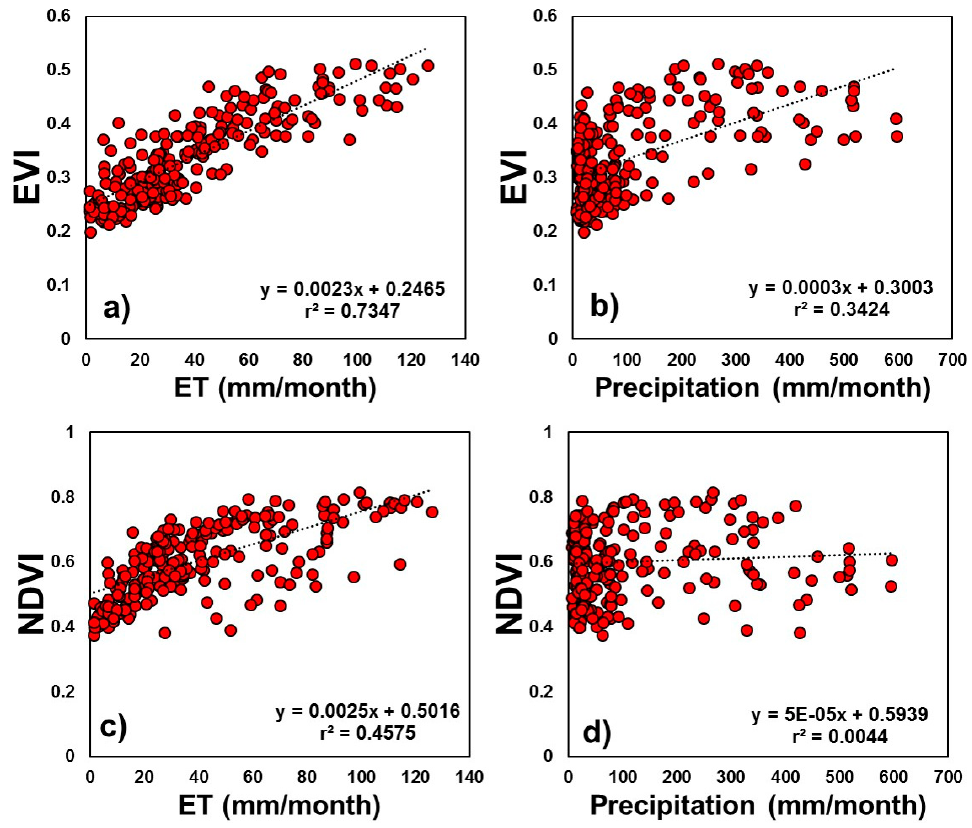
Figure 9. Relationship of mean temporal EVI plotted as a function of ( a ) evapotranspiration, ( b ) pre- cipitation, and mean temporal NDVI plotted as a function of ( c ) evapotranspiration, ( d )